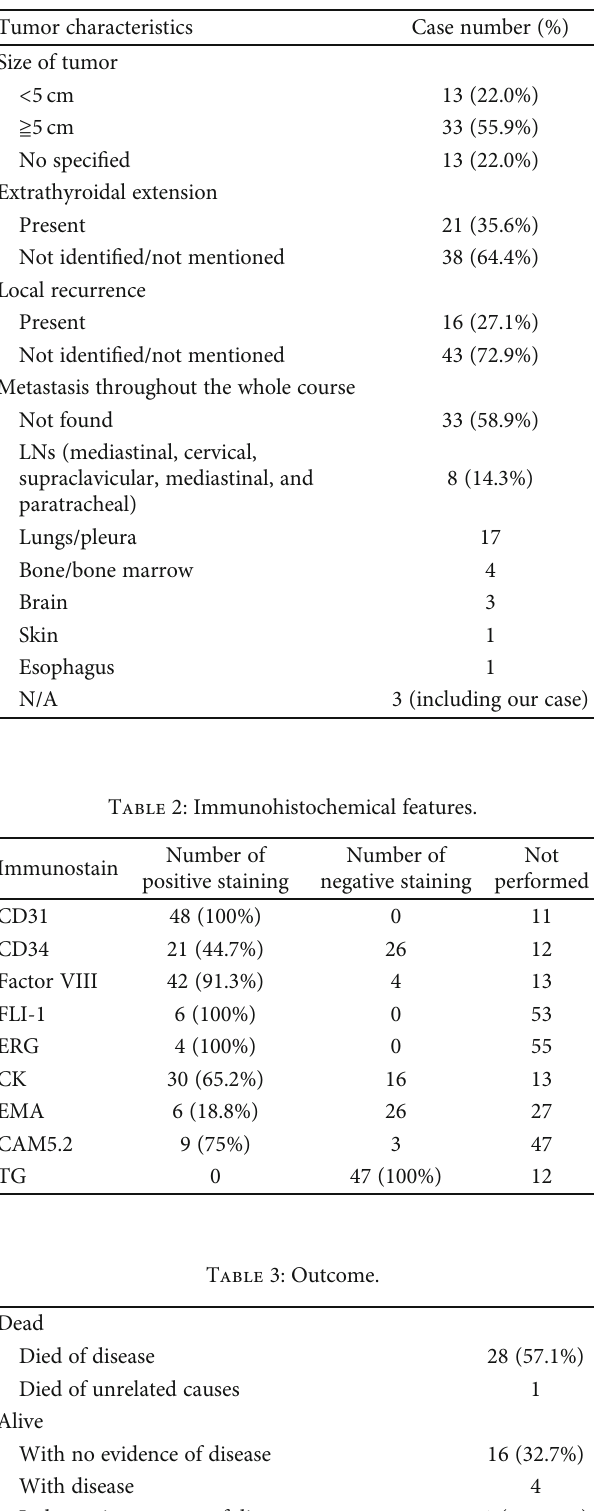
Table 1: Clinical features of enclosed patients (59 cases).